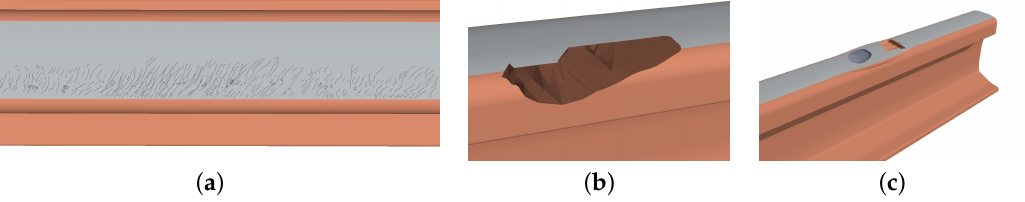
Figure 5. Three-dimensional representation of defects originating from RCF: ( a ) gauge corner checking and spalls can produce ( b ) shelling and ( c )